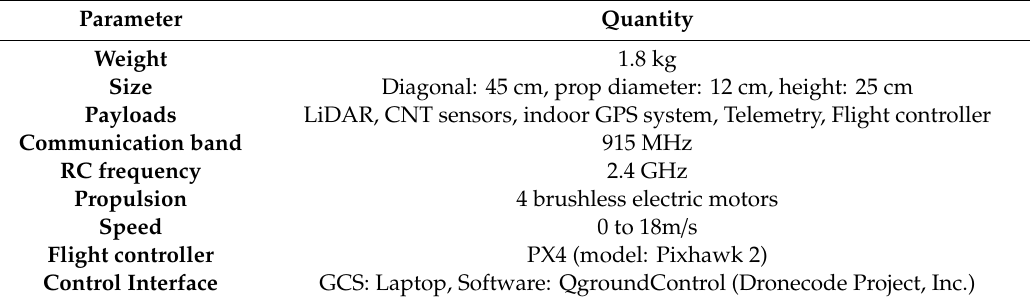
Table 1. Specifications of customized drone.